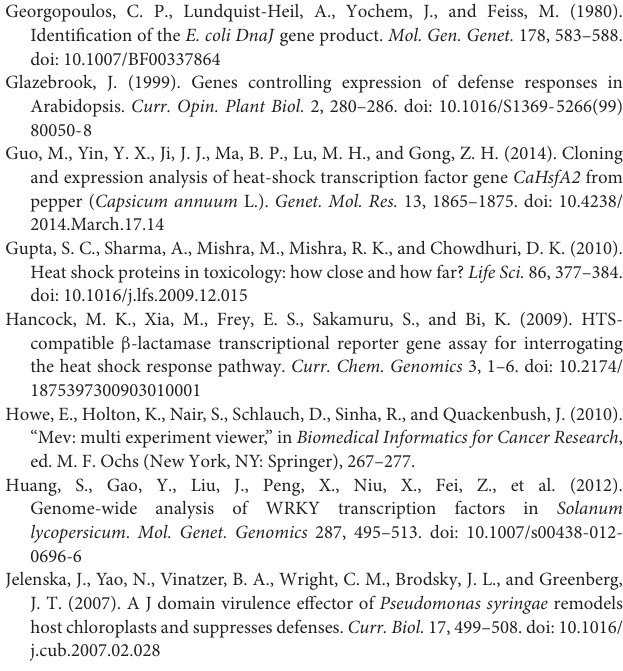
TABLE S1 | Specific primer for qRT-PCR of each CaDnaJ gene. TABLE S2 | Multiple sequence alignment of the pepper CaDnaJs. The sequences of 76 CaDnaJs were aligned according to the classification. Names of all the 76 members are showed on the left side of the figure. Conserved amino acid residues are highlighted in black. The sequences which boxed in red rectangle represented the conserved HPD motif, and sequences in yellow rectangle were zinc finger domains. TABLE S3 | Stress-related cis -elements in pepper CaDnaJ